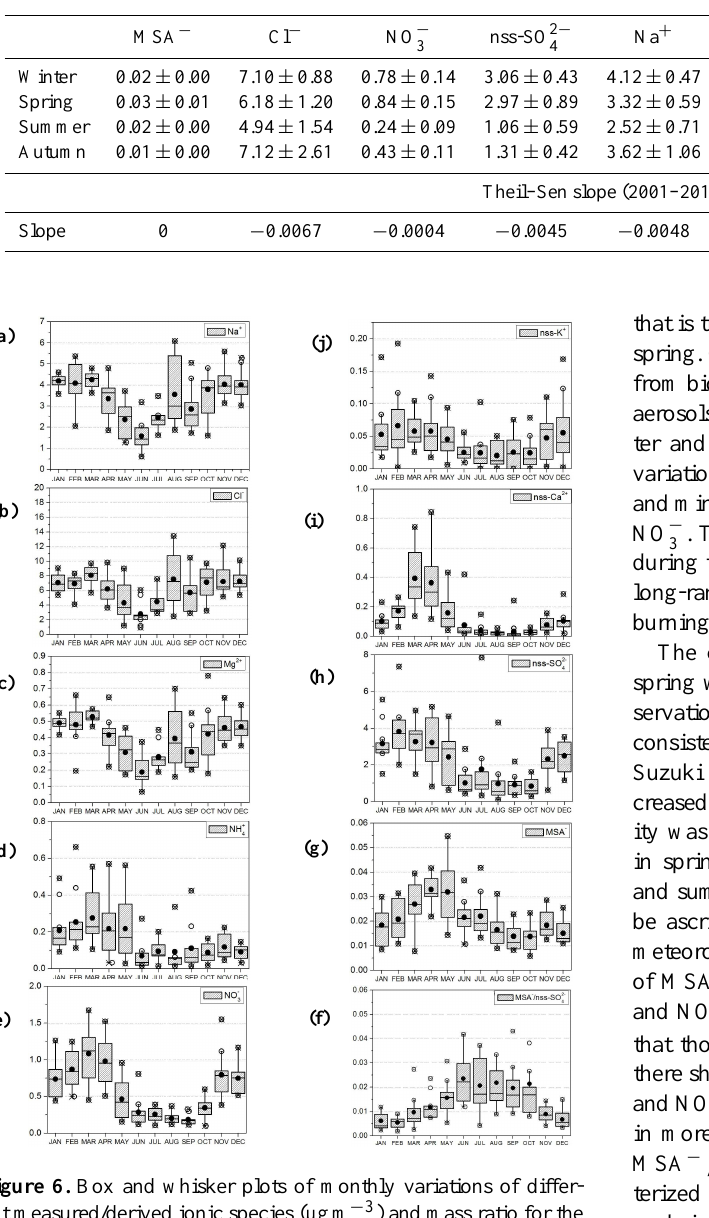
Table 1. Seasonal mean concentrations of major water-soluble ions (mean ± SD) and the Theil–Sen slope value for the seasonal trend during the period 2001–2012 at Chichijima Island in the western North Pacific.